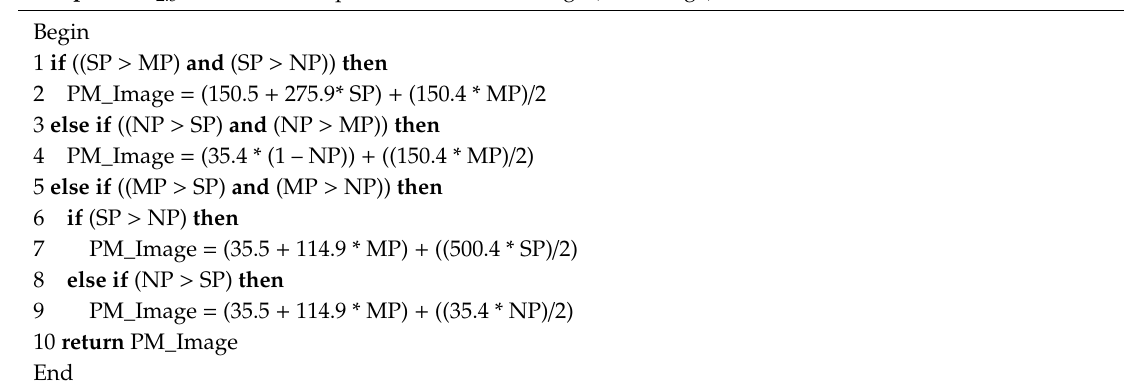
Algorithm 1: an algorithm to achieve image based prediction of PM 2.5 Input: SP denotes the normalized probability that the image belongs to Severe Pollution class; MP denotes the normalized probability of Mild Pollution class, and NP denotes the normalized probability of Nominal Pollution